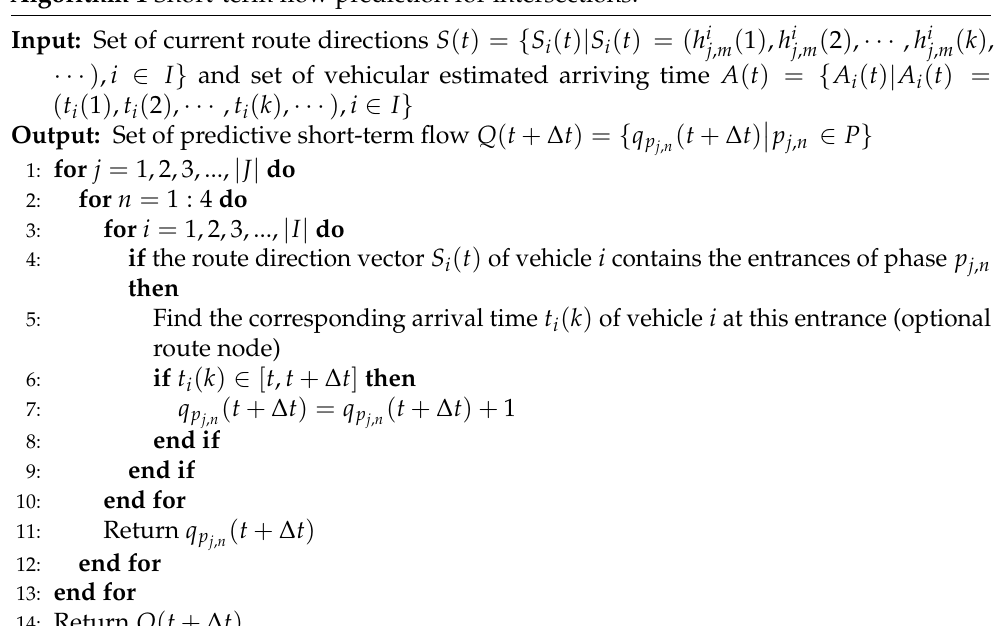
Algorithm 1 Short-term flow prediction for